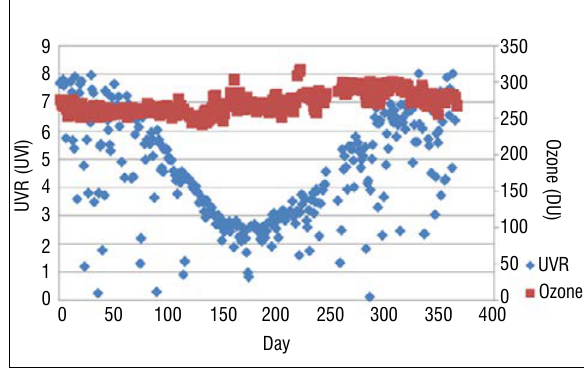
Figure 5: Distribution of solar ultraviolet radiation (UVR) and ozone over Pretoria for the year 2012. From Figure 6 it can be seen that the shape of the distributions for the satellite-measured solar UVR and the ground-based solar UVR are very similar; on both occasions, higher values are generally observed in